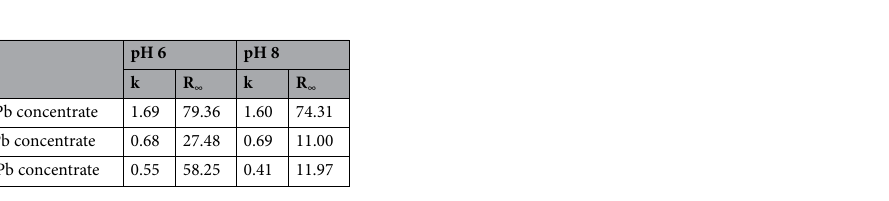
Table 3. Flotation kinetics rate parameters for lead, zinc, and iron in the lead flotation